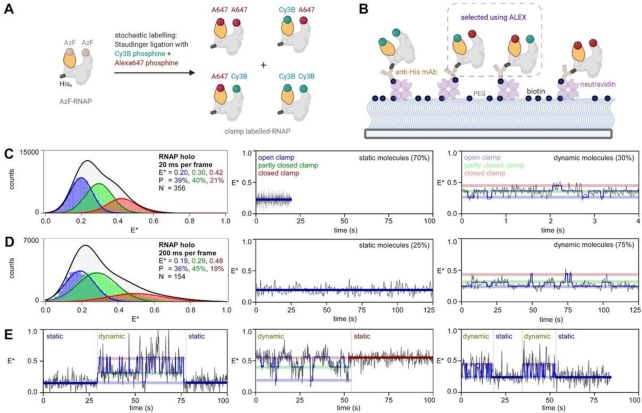
RNAP clamp switches between long-lived and short-lived conformational sub-states. (A) Stochastic labeling strategy used for generating clamp-labelled RNAP. Positions of donor (Cy3B), acceptor (Alexa647) and β′ C-terminal hexahistidine tag are shown; Grey, RNAP; Yellow, clamp. (B) Schematic showing experimental strategy for smFRET on surface immobilized clamp-labelled RNAP. (C) (left) Histograms and Gaussian fits of HMM-derived E* distributions from experiments with 20-ms frame rate for all molecules, showing open (blue), partly closed (green) and closed (red) clamp states; P, subpopulation percentage. N, number of molecules; black line, sum of gaussian fits to the three states; (middle) representative time traces of FRET efficiency, E*, showing a molecule in a static open clamp state. (right) representative time trace of E*, for a dynamic molecule showing hidden-Markov-model (HMM)-assigned states and interstate transitions (blue line). Laser powers were 3.5 mW in green and 0.75 mW in red. (D) (left) Histograms and Gaussian fits of HMM-derived E* distributions from experiments with 200-ms frame rate for all molecules; Colors and symbols as in C; (middle) representative time trace of E*, showing a molecule in a static open clamp state. (right) representative time trace of FRET efficiency, E*, for a dynamic molecule showing HMM-assigned states. Laser powers were 0.20 mW in green and 0.075 mW in red. (E) (left) Time trace of E*, showing transition between a static open clamp status to a dynamic status (middle) time trace of E*, showing transition between a dynamic status to a static closed clamp status (right) time trace of E*, showing transitions between dynamic and static clamp status. Laser powers and frame rate as in D.